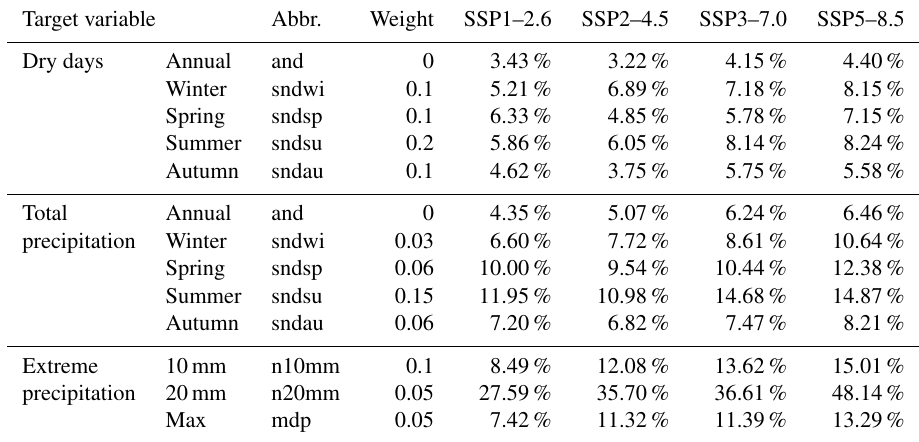
Table 7. Maximum deviation relative to the mean change factor projected by the CMIP6 ensemble allowed for acceptance for each target variable in WG. These deviations correspond to a 95% confidence interval of the distribution of each target variable projection within the GCM